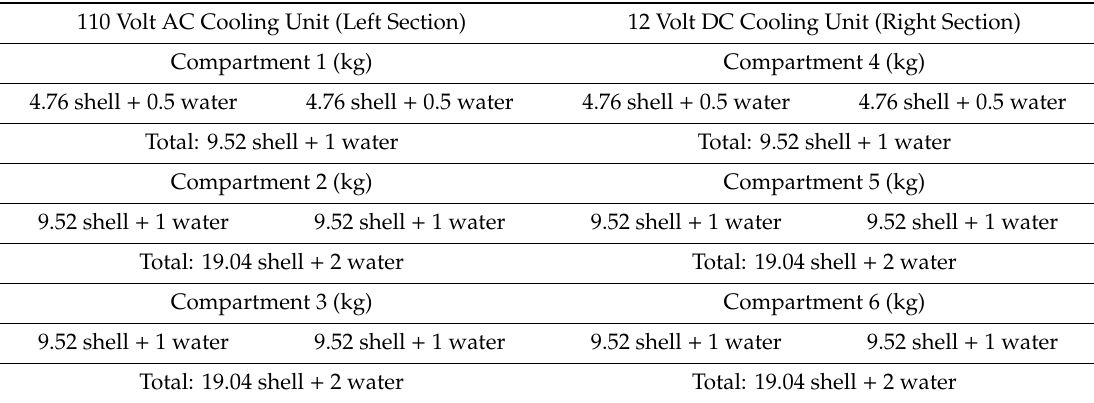
Table 1. Distribution of oyster shell and water in the cooling